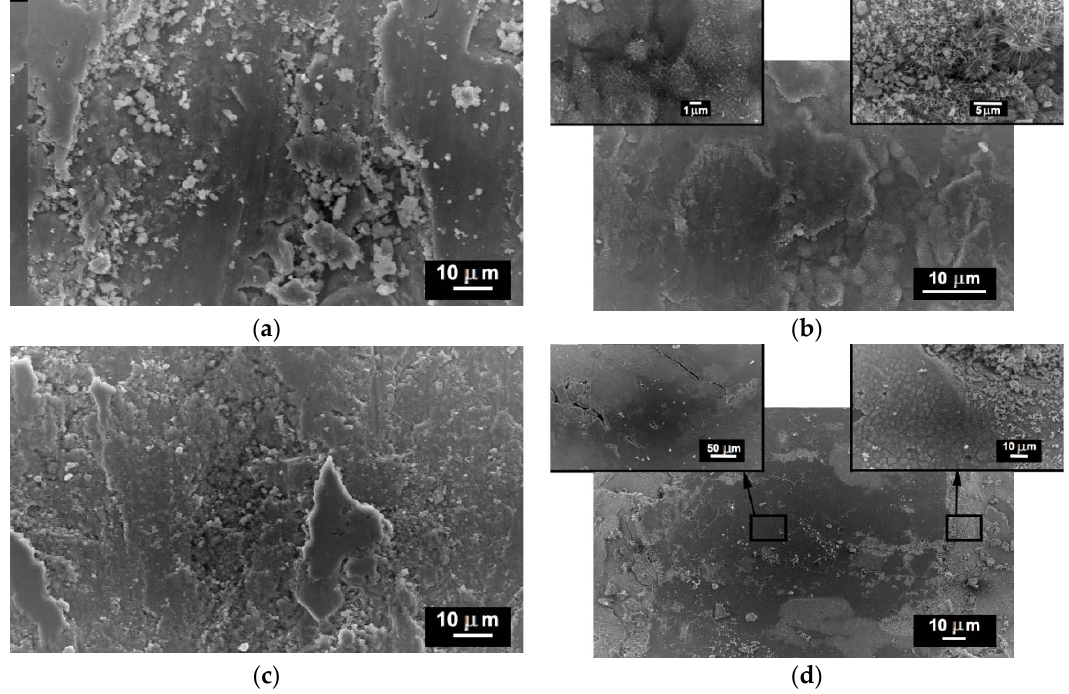
Figure 9. Wear debris after the ball-on-disk tests: ( a ) coating 1—400 °C, ( b ) coating 1—800 °C, ( c ) coating 2—800 °C, and ( d ) coating 3—800 °C.